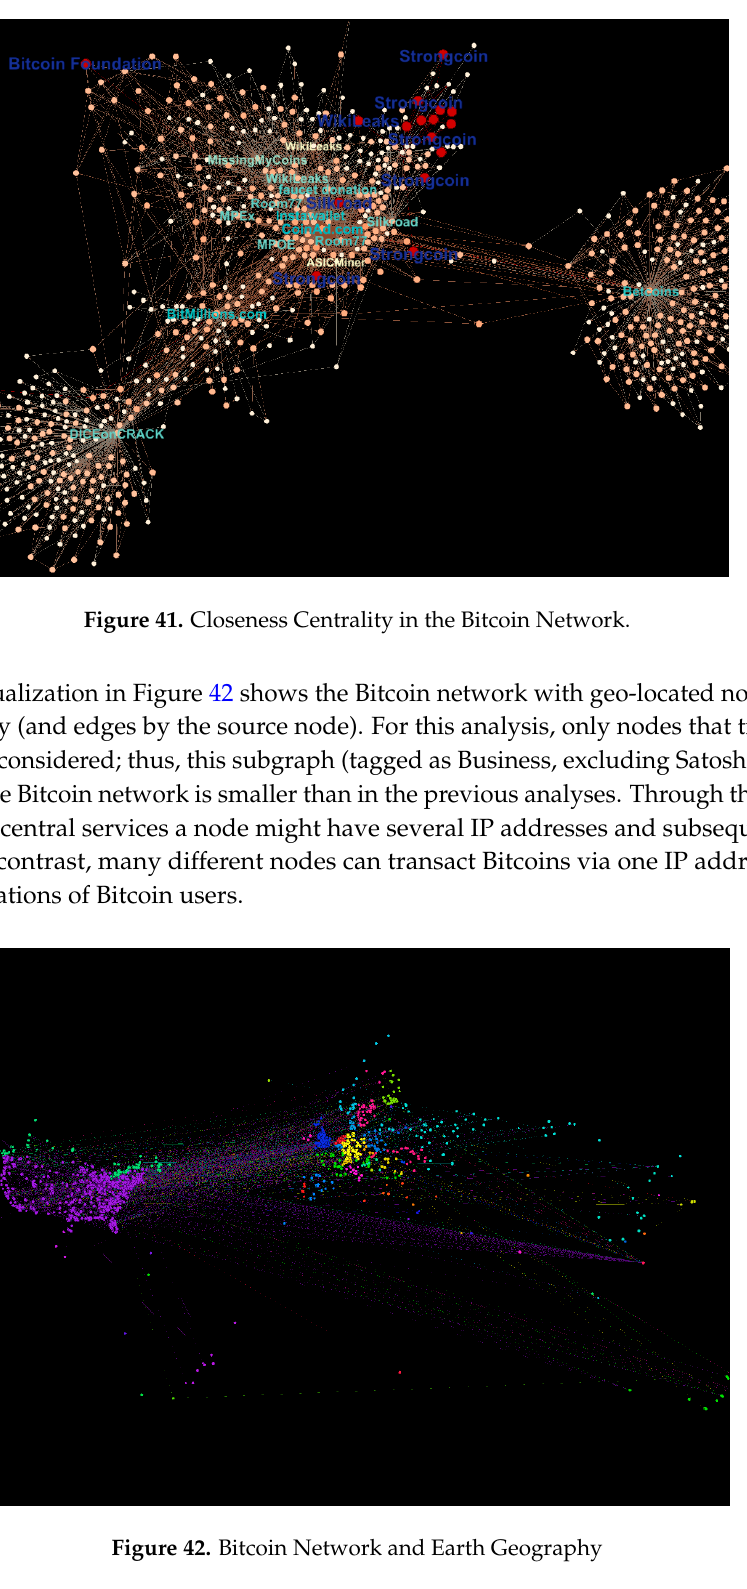
Figure 40. Betweenness Centrality in the Bitcoin Network.